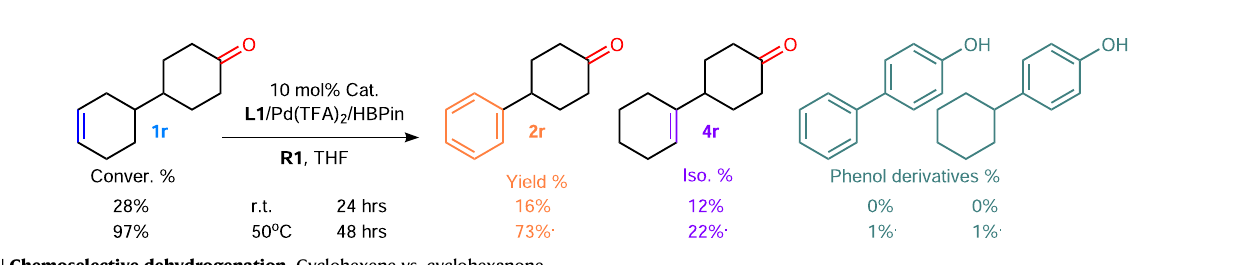
Fig. 9 | Chemoselective dehydrogenation. Cyclohexene vs.